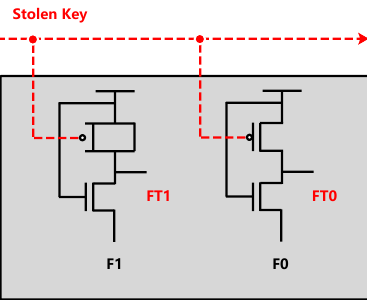
Figure 9. A special HT without trigger.